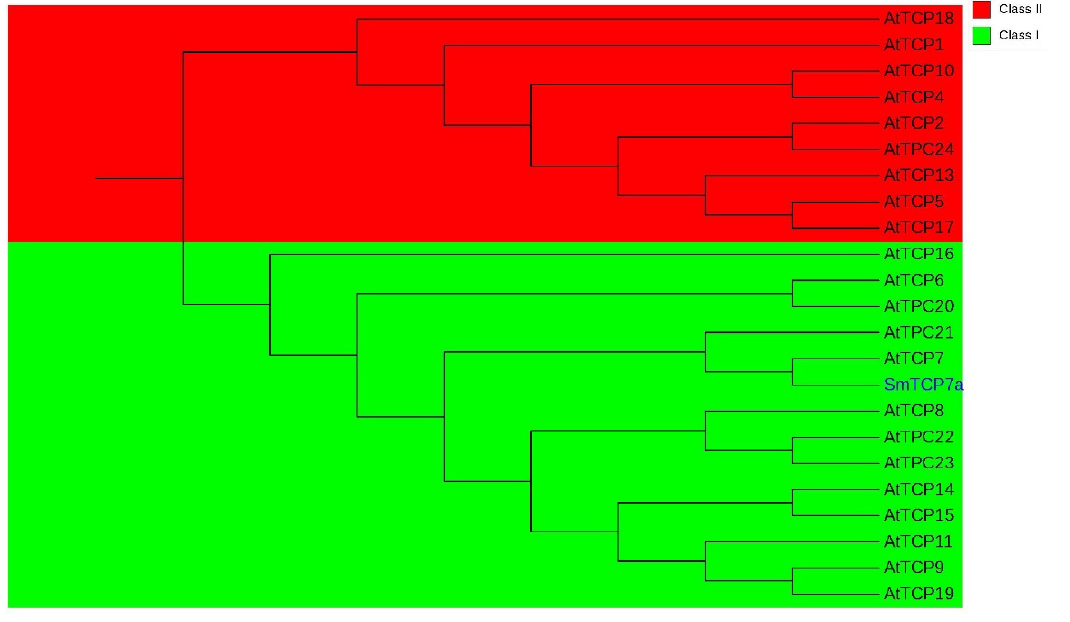
Figure 1. The phylogenetic tree for SmTCP7a. The phylogenetic tree was analyzed by NJ tree with 1000 bootstrap replicates. Figure 2. The subcellular location of SmTCP7a. SmTCP7a-YFP was detected using Nicotiana ben- thamiana leaves. Bar = 20 μ m.